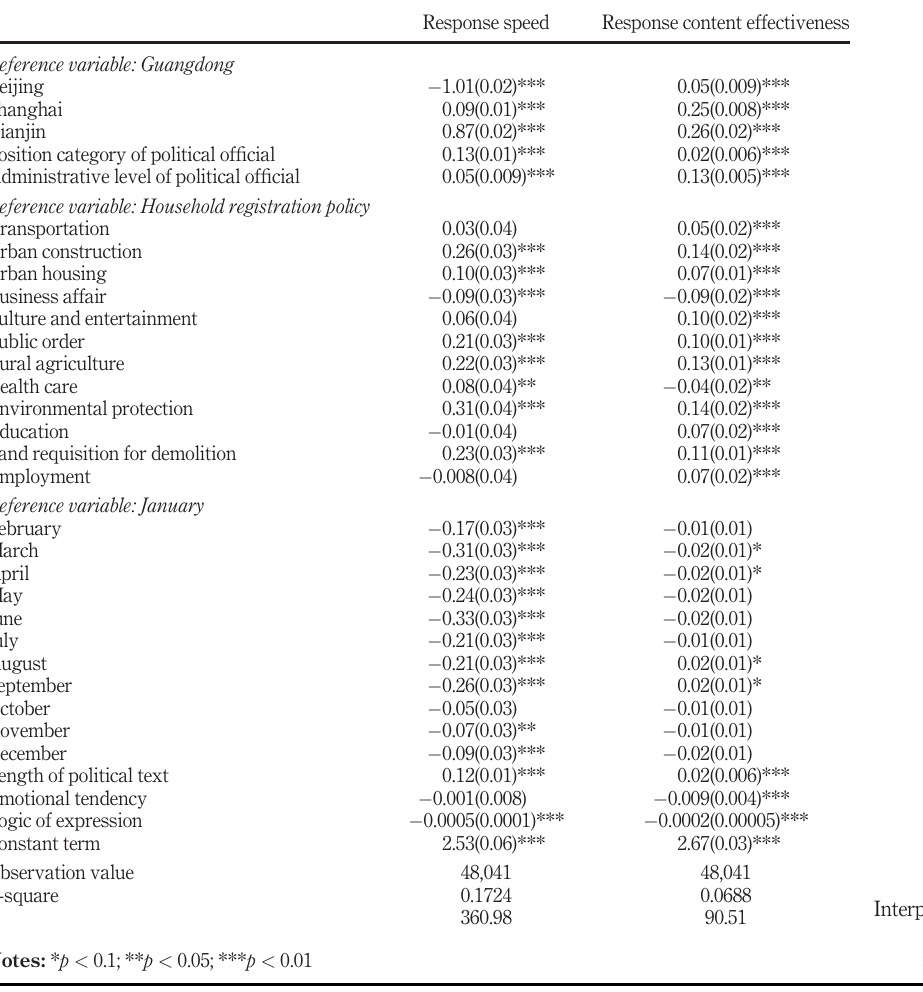
Table 5. Interpretation